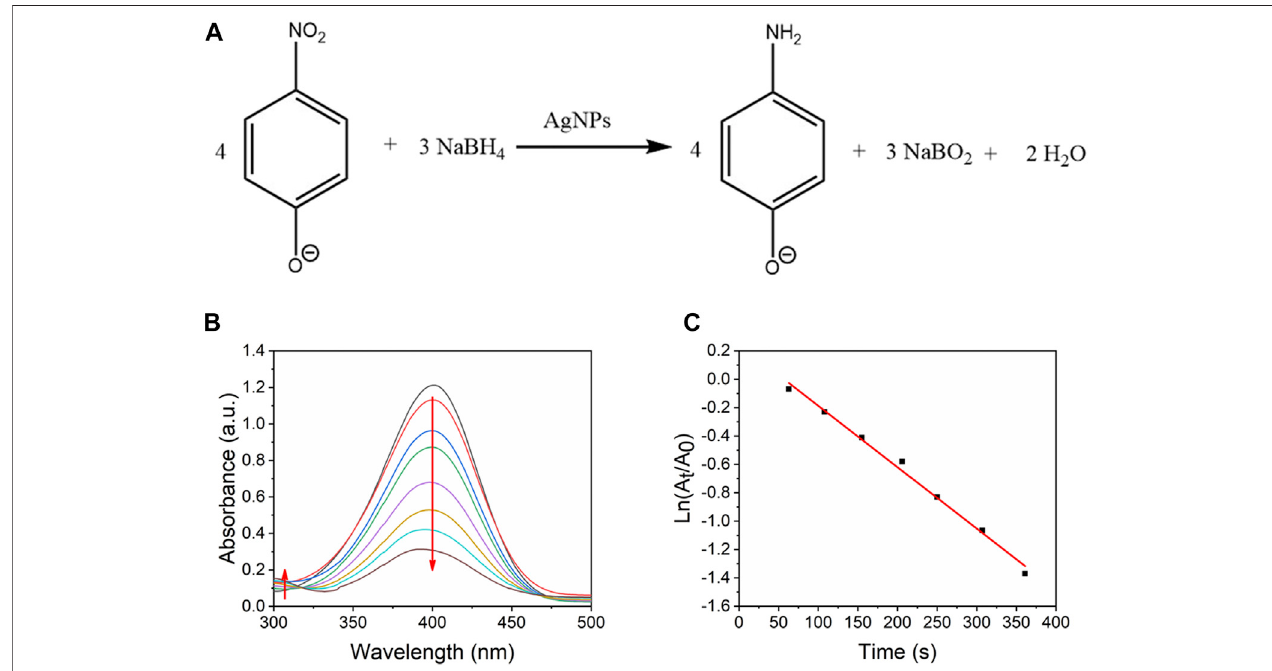
FIGURE10|(A) Reduction of4-NP to4-AP by excessNaBH 4 . (B) UV-visabsorptionspectraofreductionof4-NP byAg/SBA-15 synthesizedat 17.5 sresidence time as a function of time. (C) Kinetic analysis of the reaction.